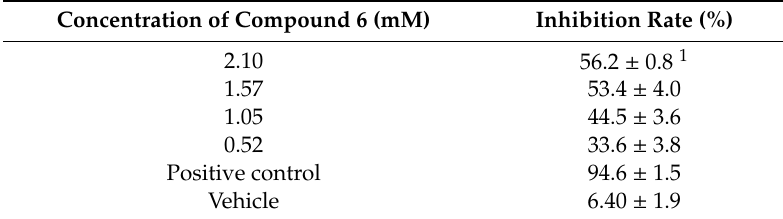
Table 3. The inhibition rate of compound 6 against acetylcholinesterase